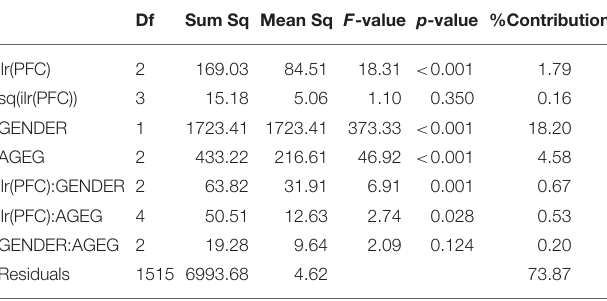
TABLE 3 | Analysis of variance table for visceral fat area.